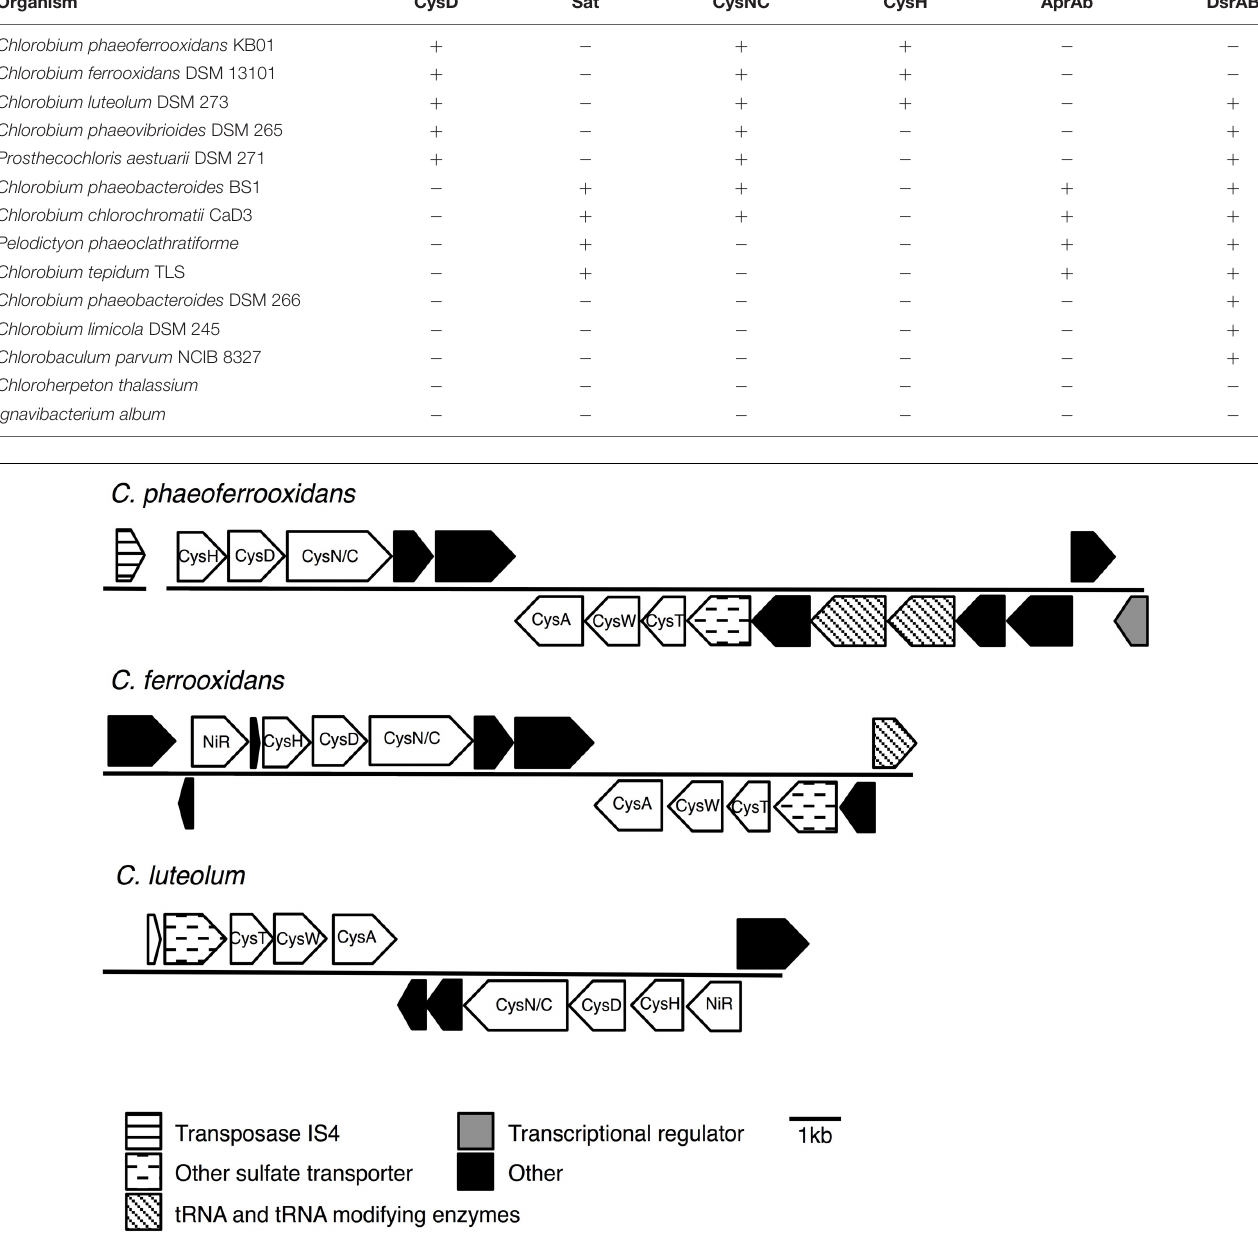
Fe(II). This implies the fixation of 770 µ M C, based